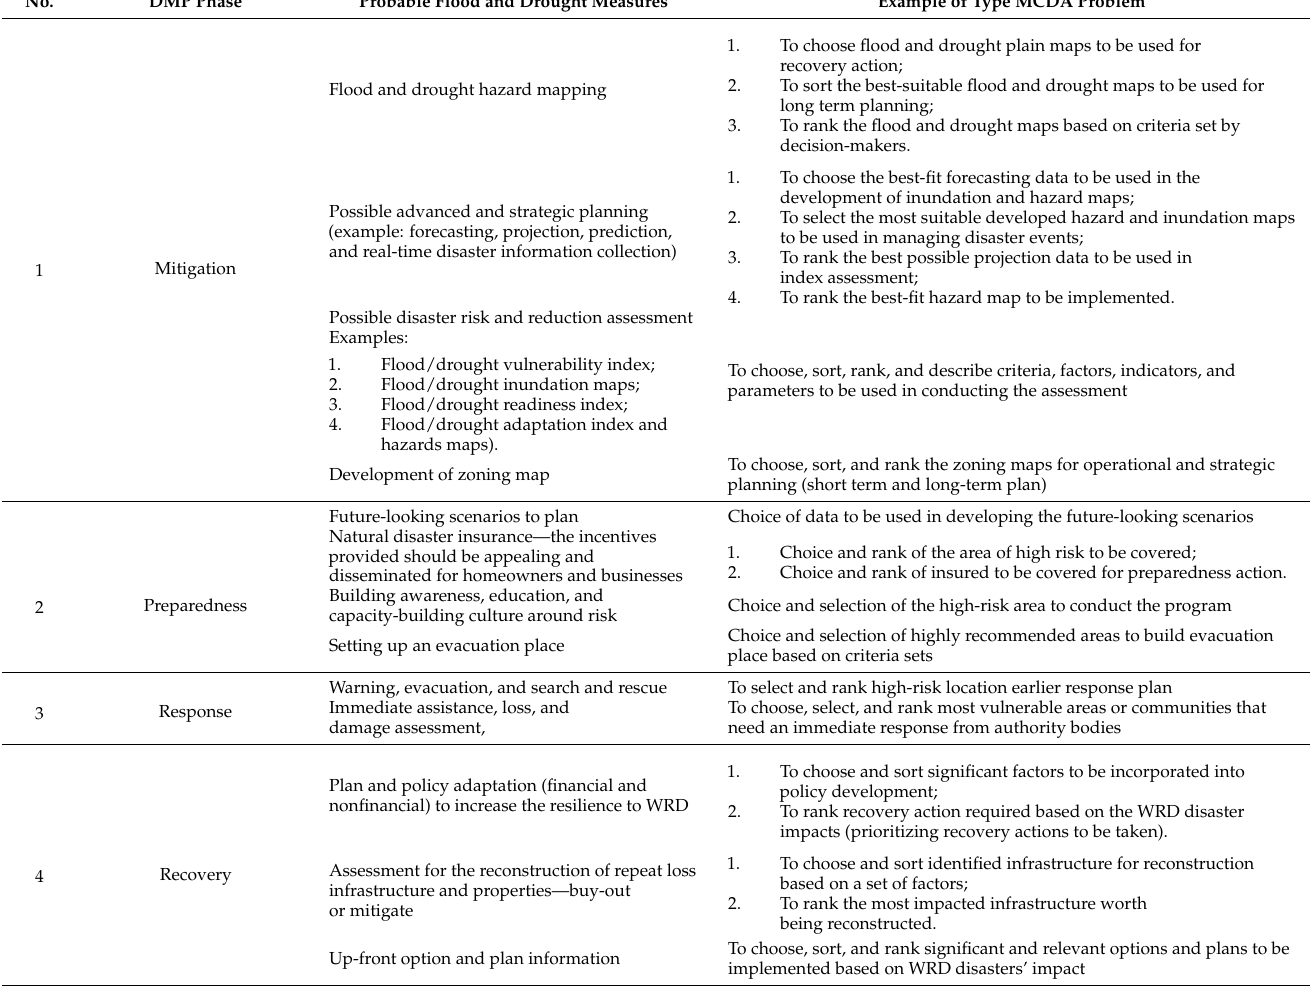
Table 14. Possible measures according to